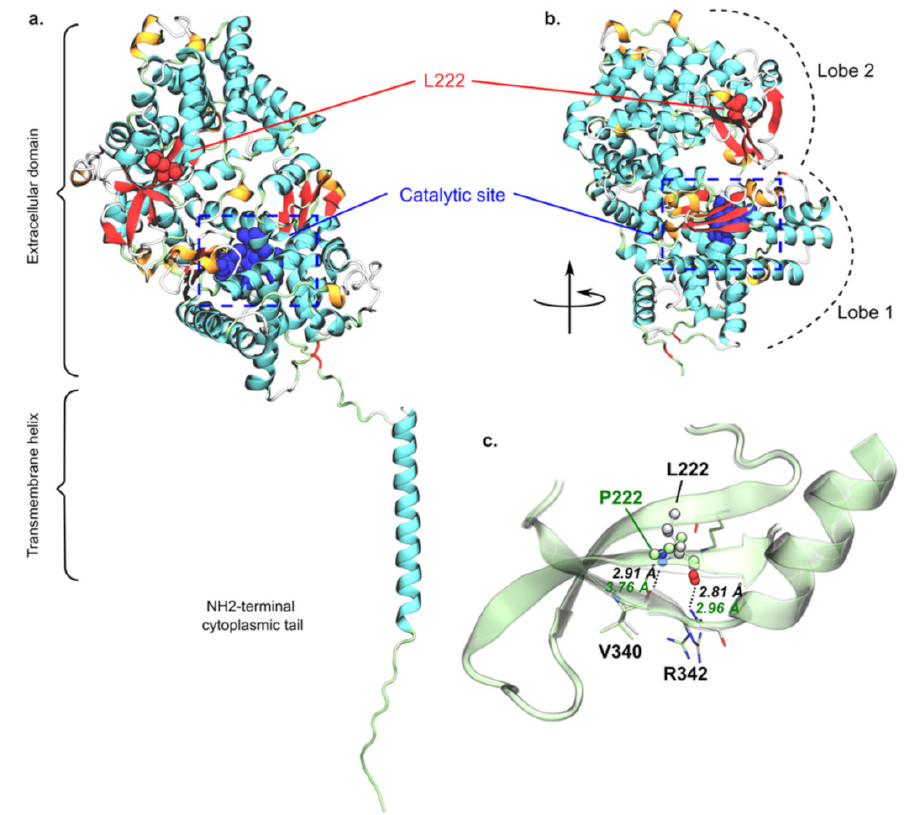
Figure 7. Predicted structure of PHEX and putative rationalization of L222P mutation. Overall predicted structure of wildtype PHEX obtained from AlphaFold2 ( a ) as well as the extracellular domain folding into bi-lobe structure ( b ), in which L222 and the catalytic site are depicted in red and blue, respectively. L/P222 regions of wildtype PHEX and PHEX L222P models were superimposed, ( c ) highlighting key predicted inter- β -sheet H-bonds of wildtype PHEX (black) and PHEX L222P (green). Pictures were rendered using the VMD